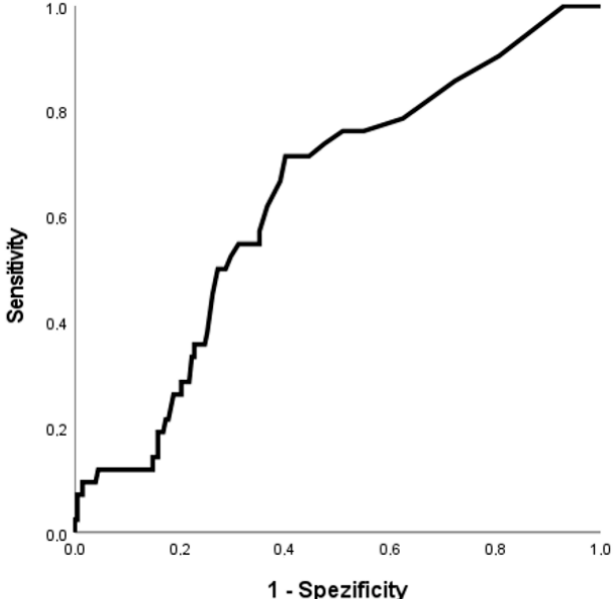
Figure 3. Receiver operating characteristic (ROC) curve showing the discrimination of initial highly sensitive troponin T (hsTnT) for AKI within 72 h.